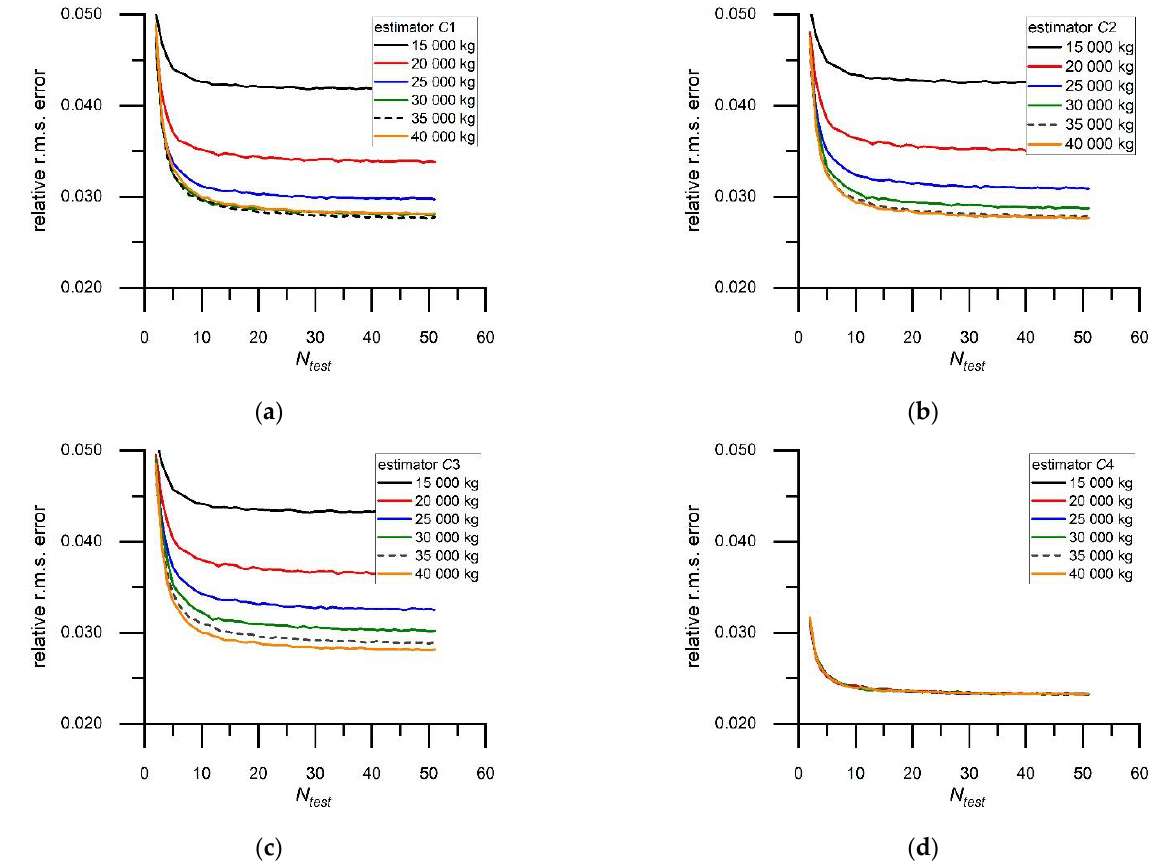
Figure 4. Influence of the weight distribution of test vehicles in the measurement range of the WIM system on the rms error of vehicle weighing results for various estimators of calibration coefficients ( 𝐶 𝑟𝑒𝑓 = 1 , 𝑏 𝑟𝑒𝑓 = 0.1𝑍 𝑚𝑖𝑛 ). ( a ) estimator 𝐶1 , ( b ) estimator 𝐶2 , ( c ) estimator 𝐶3 , ( d ) estimator 𝐶4 .